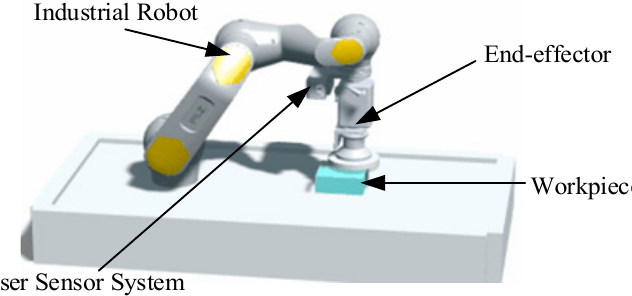
Figure 13. Robot laser scanning and grinding method.